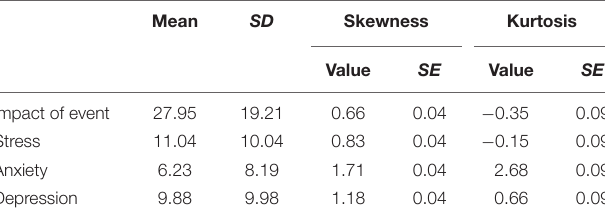
TABLE 1 | Means, standard deviations, Skewness and Kurtosis for Impact of event, stress, anxiety, and